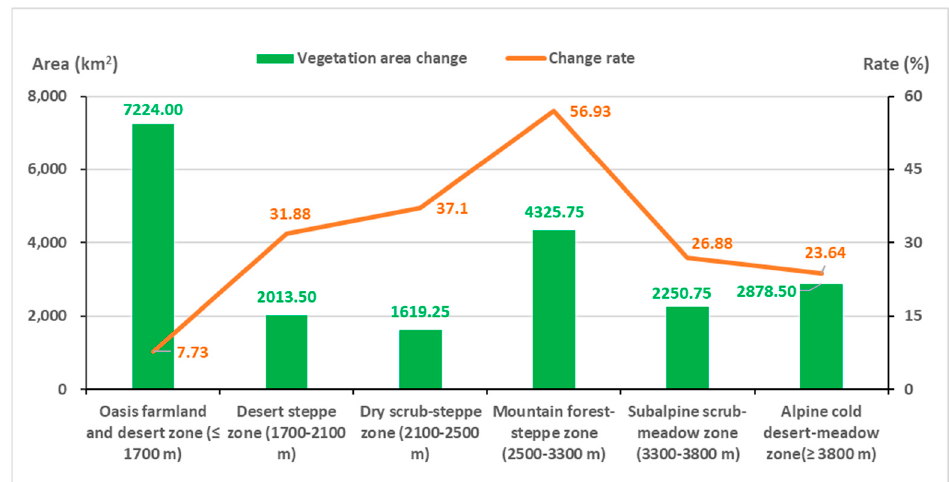
Figure 4. Change trends of vegetation distributed in the different elevation zones between the 1980s and the 2010s.